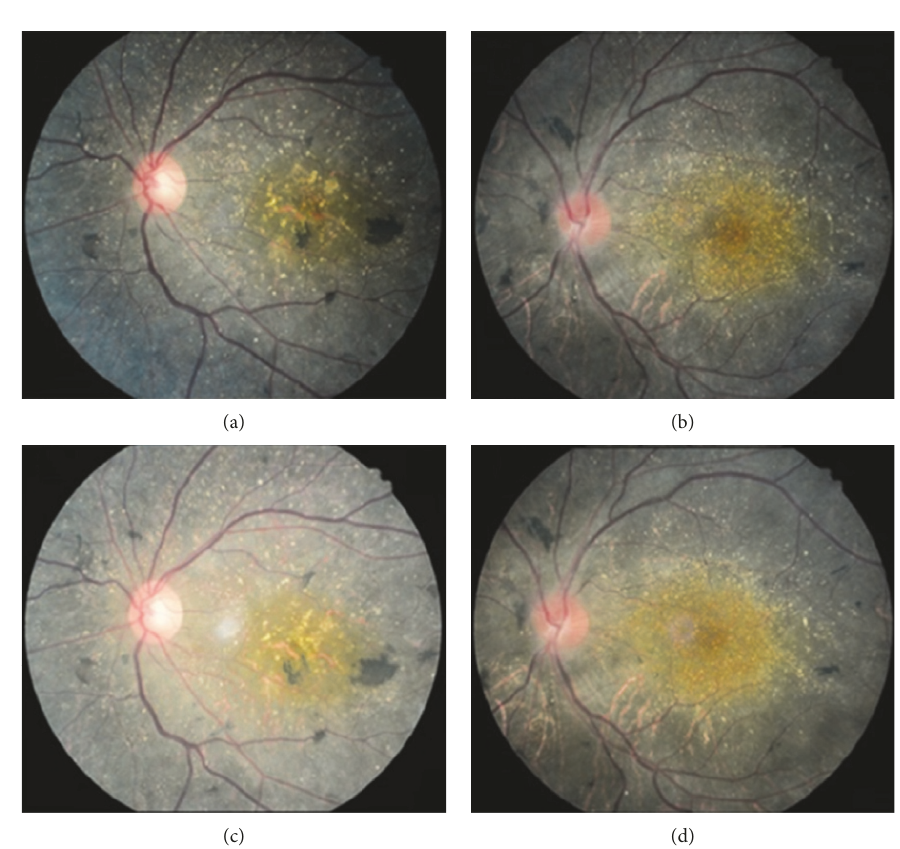
Figure 2: Comparison of first and last fundus color photographs in patients with type 1 and type 2 BCD. (a, c): Color fundus images of the left eye of type 1 patient P2 at the first and last visit, respectively, show a significant reduction of crystalline material. (b, and d): Retinal changes were not obvious in the macula area of the left eye of type 2 patient P4. The crystalline deposits of the retina surrounding macula area were significantly